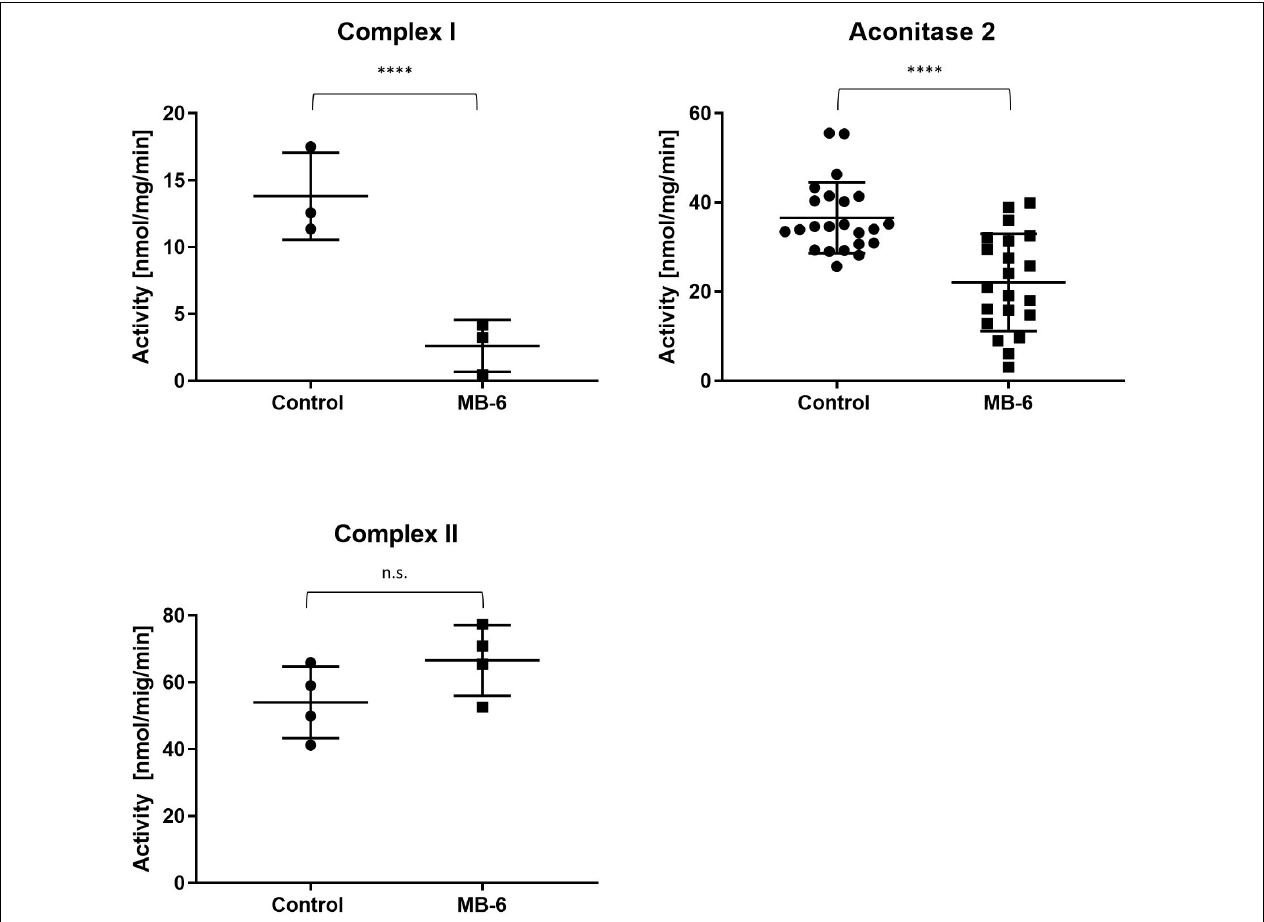
FIGURE 4 | Selected Fe-S cluster protein activities are negatively affected by MB-6 treatment. Upon MB-6 treatment, complex I activity as well as aconitase II activity drop significantly, whereas complex II activity remains unchanged. ∗∗∗∗ p <